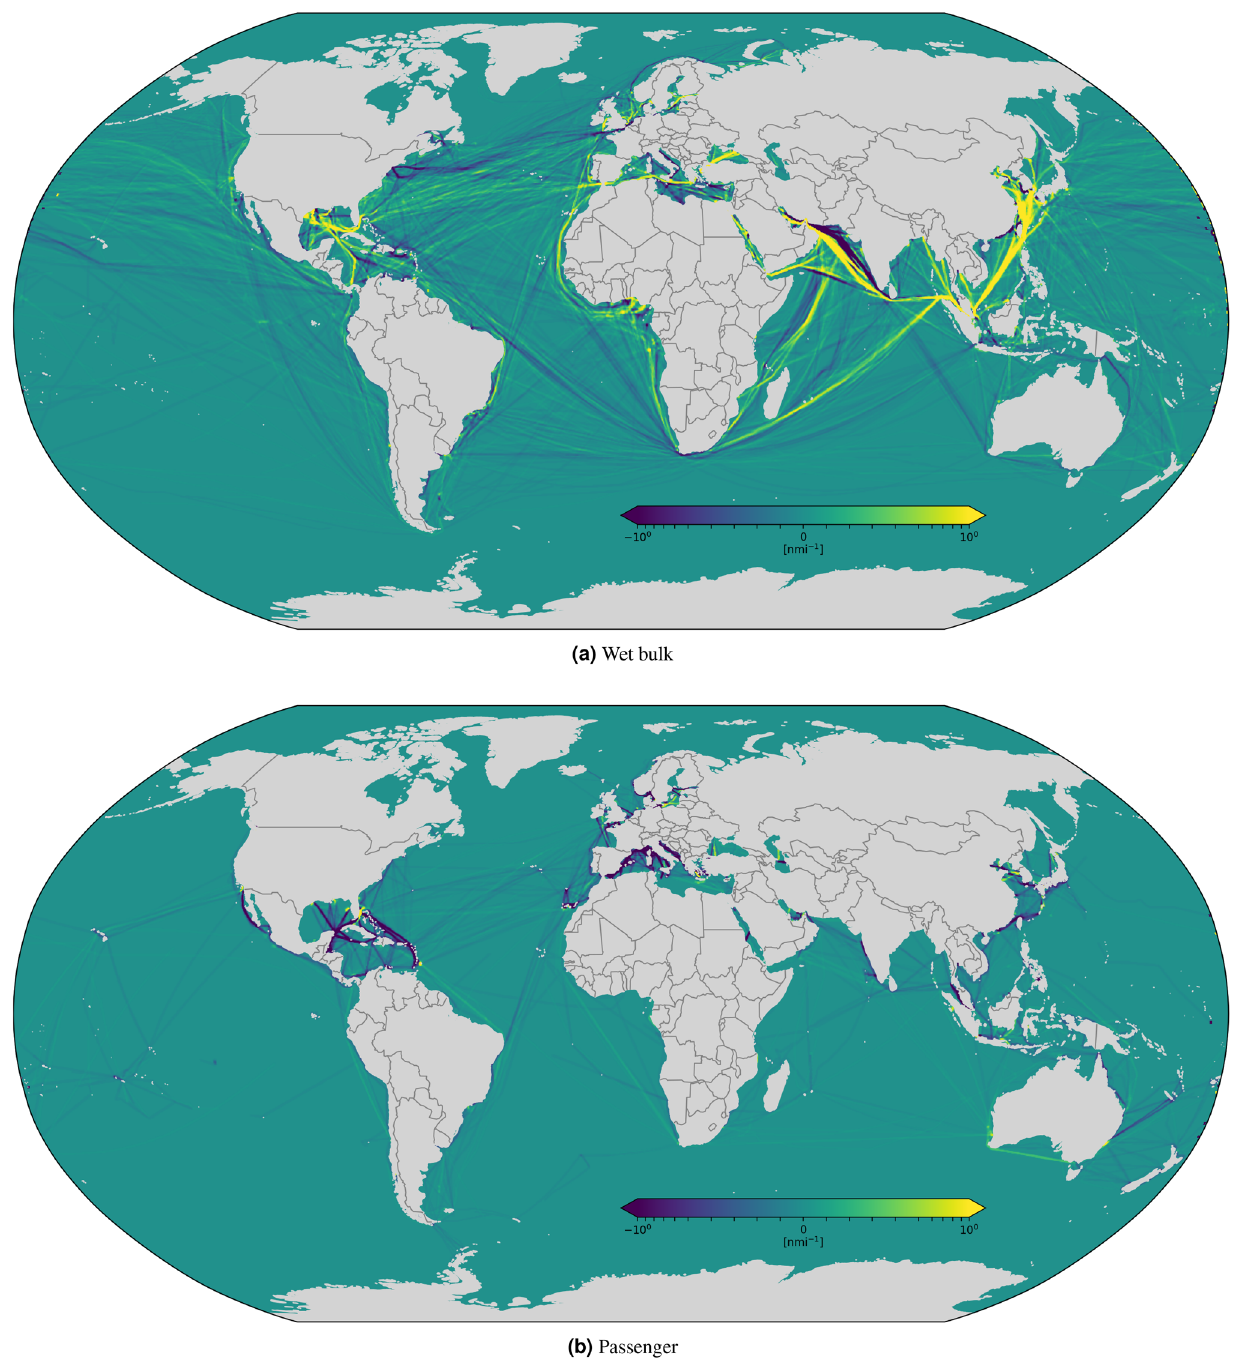
Figure 6. Monthly CNM density difference between 2020 and 2019 for wet bulk ( a ) and passenger ( b ) shipping. The considered time period is from 13 March to 13 April. Each grid cell is colored based on the variation of the 2020 value with respect to 2019, ranging from dark purple, which represents a decrease of CNM in 2020 with respect to 2019, to bright yellow, which represents instead an increase of navigated miles in 2020 with respect to the previous